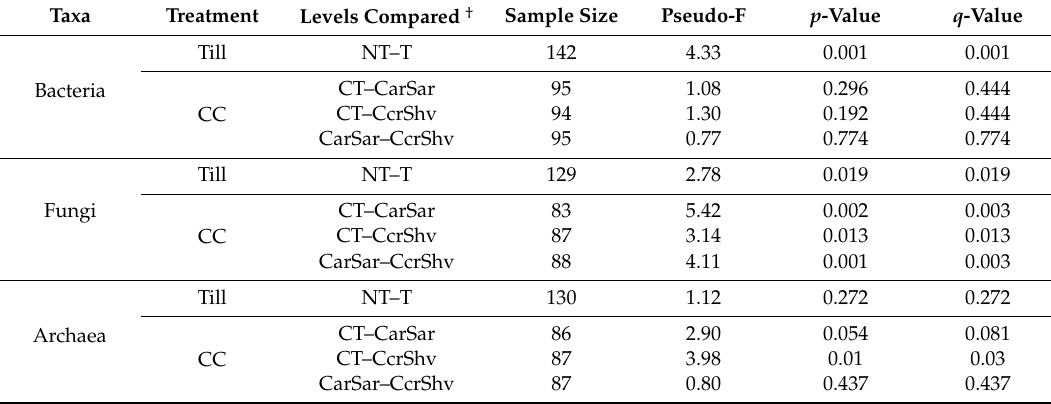
Table 3. Community structure ( β -diversity) measures for bacteria, fungi, and archaea sampled following five years of tillage (Till) and cover crop (CC) treatments, based on pairwise PERMANOVA on weighted UniFrac distances. The pseudo-F measures the significance of the UniFrac distance between the two treatment levels compared, while the p -value and q -value indicate the probability of type I and type II errors associated with each comparison,